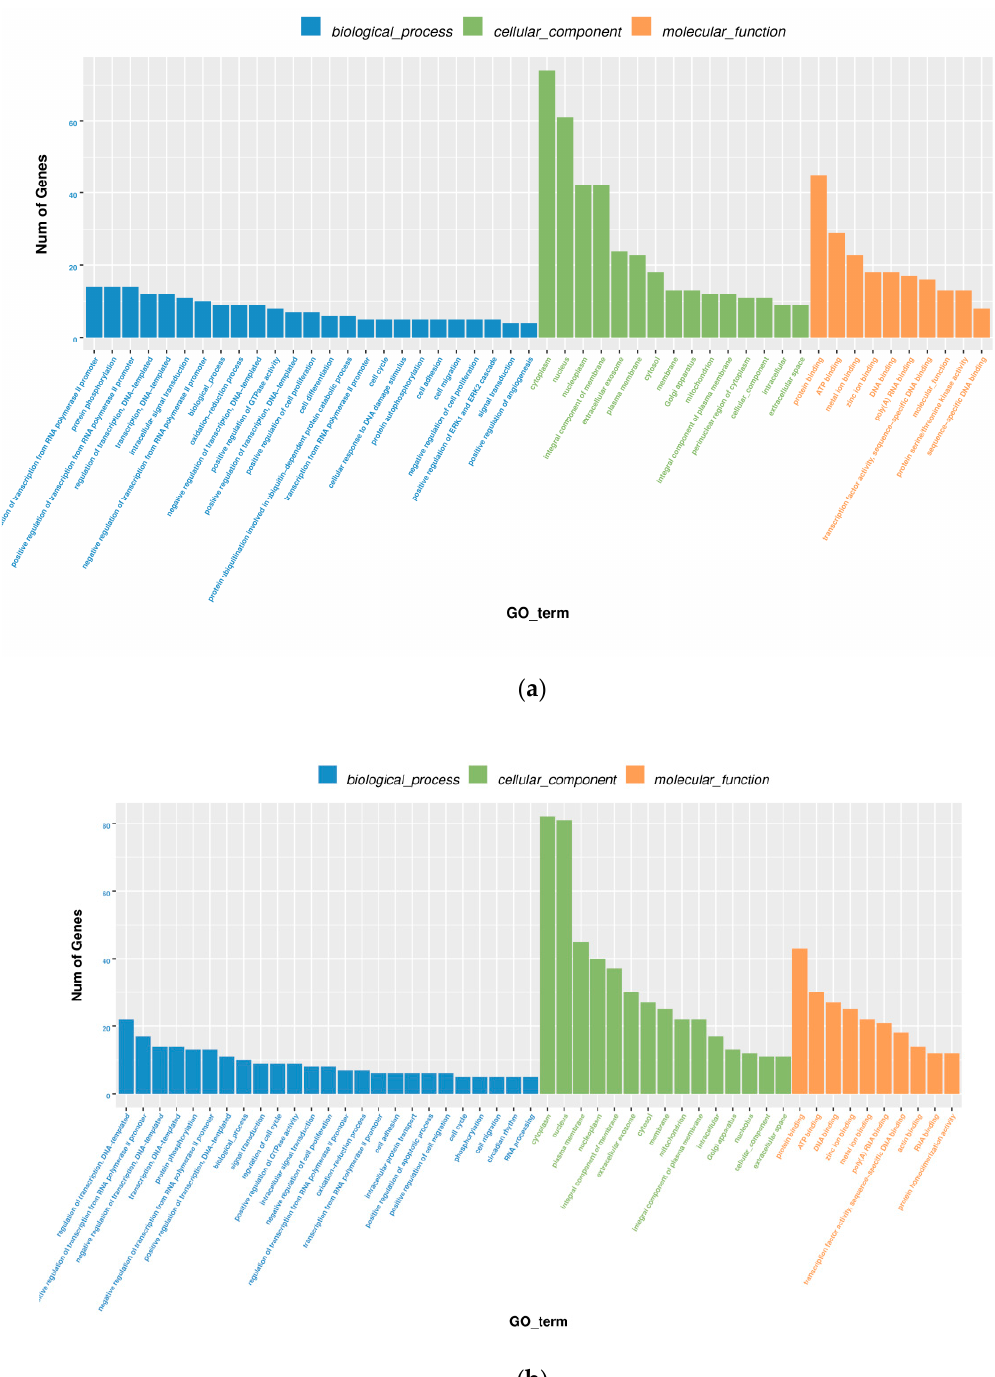
Figure 7. GO enrichment analysis of the ceRNA network. ( a ): WB vs SB. ( b ): WT vs ST. WB, WT, SB, and ST represent WuTou donkey longissimus dorsi muscle, WuTou donkey gluteus muscle, SanFen donkey longissimus dorsi muscle, and SanFen donkey gluteus muscle, respectively.